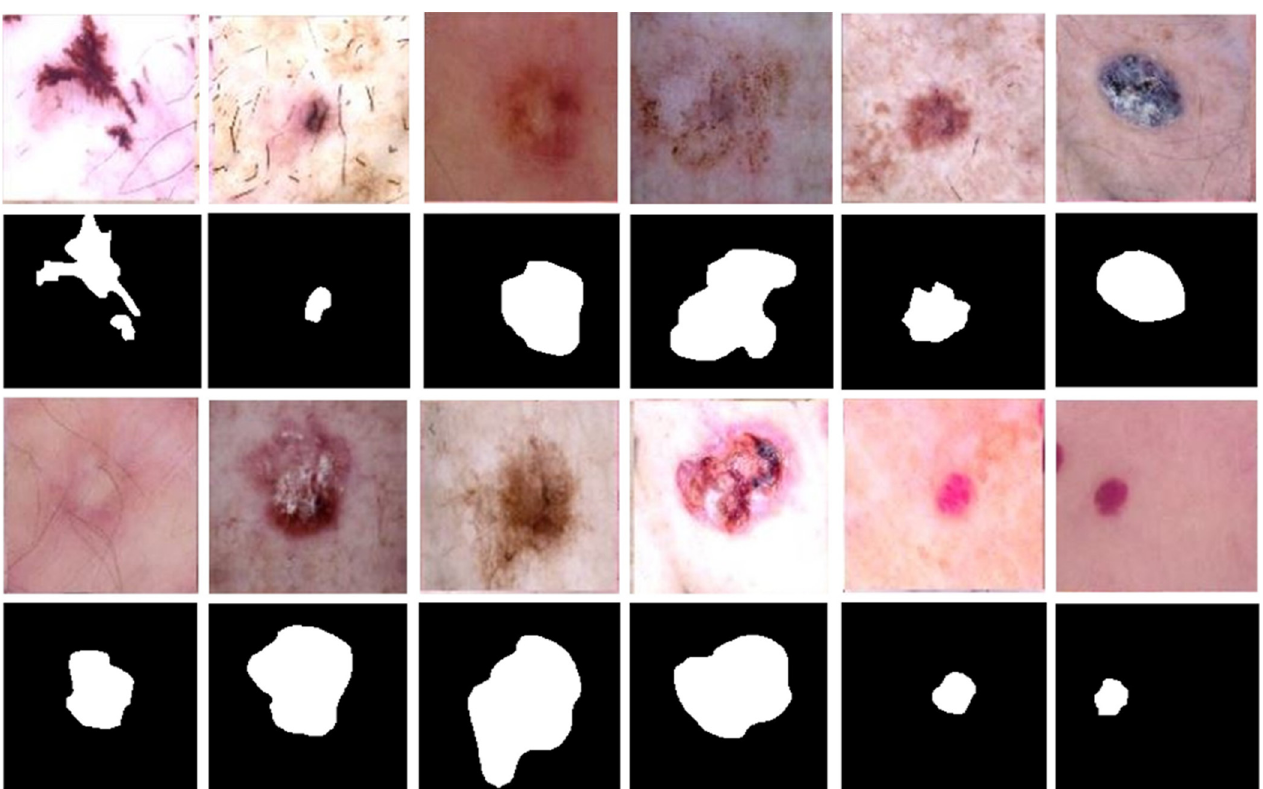
Figure 7. Evaluation results on the HAM10000 dataset. As can be seen in the second and the fourth rows, the results are precise and clear.